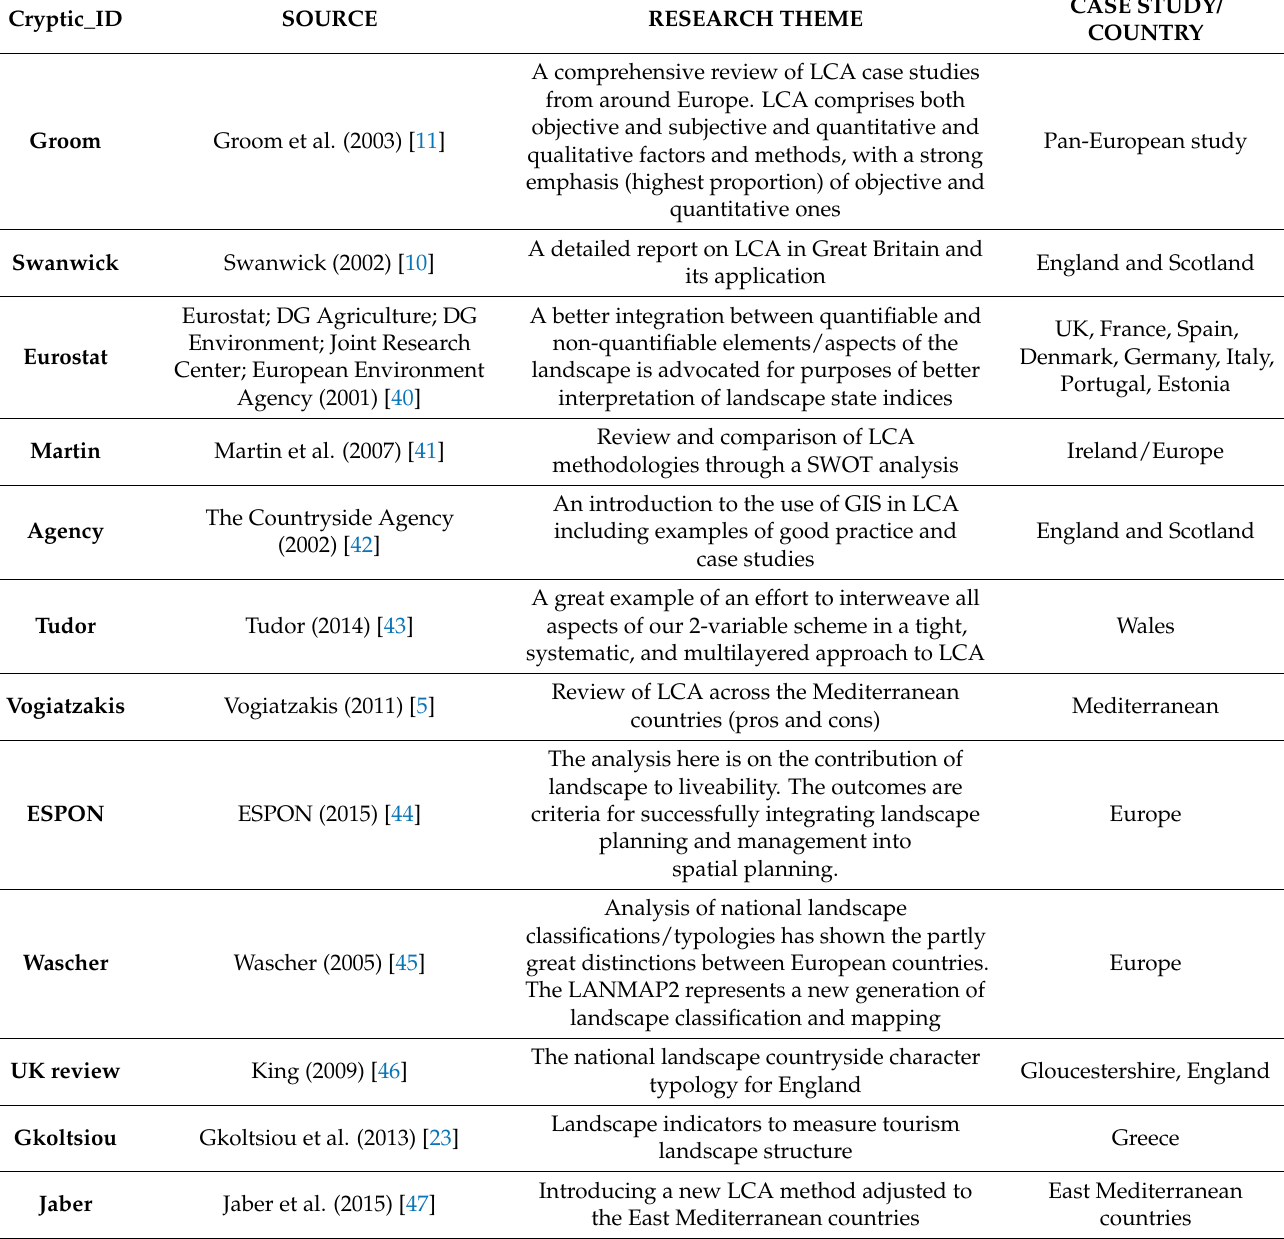
Table 1. The database of bibliographical sources used for the